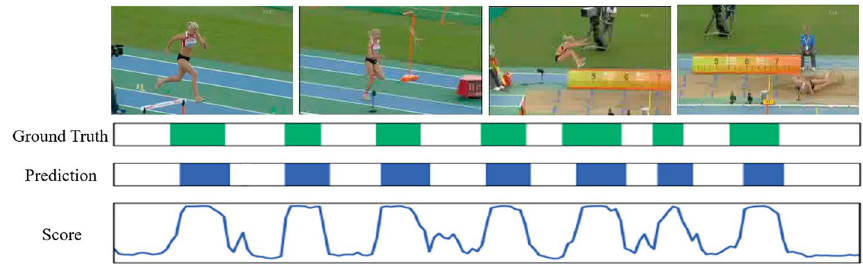
Fig. 6 Temporal action localization experiment on THUMOS14. The horizontal axis denotes time, we sequentially plot the ground truth, predicted localization, and prediction